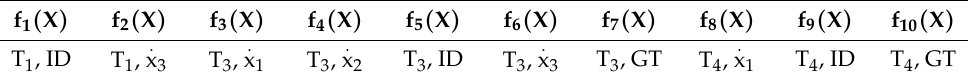
Table 1. Assignment of the individual objective functions to individual experiments.